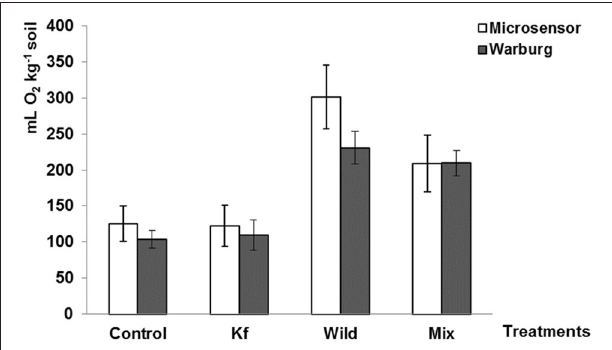
FIGURE 4 | O 2 assimilation rate measured by oxygen optical microsensor (white) and Warburg (black) manometer (Mean, n = 12, ± SE). Control: pure ReviTec ® soil, Kf: ReviTec ® soil plus laboratory cultured filamentous algae K. flaccidium , Wild: ReviTec ® soil plus wild algae population, Mix: ReviTec ® soil plus mixed cultures of K. flaccidium and wild population. Warburg data was kindly provided by Thomas